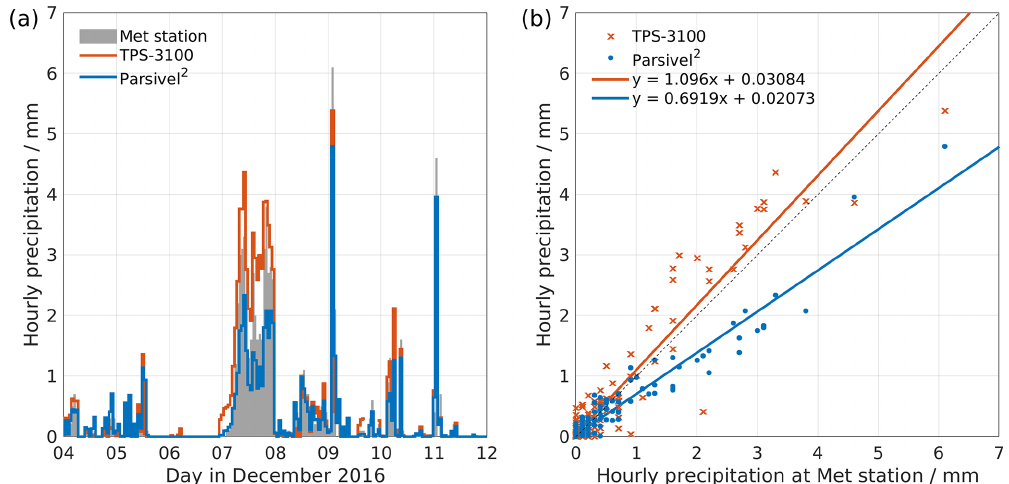
Figure A1. (a) Hourly rain rate during 4–11 December 2016 measured by rain gauge at WMO station (shading), TPS-3100 (red), and Parsivel 2 (blue). (b) Scatter plots and corresponding fits for the measurements of TPS-3100 (red cross) and Parsivel 2 (blue dot) against those from the rain gauge at WMO